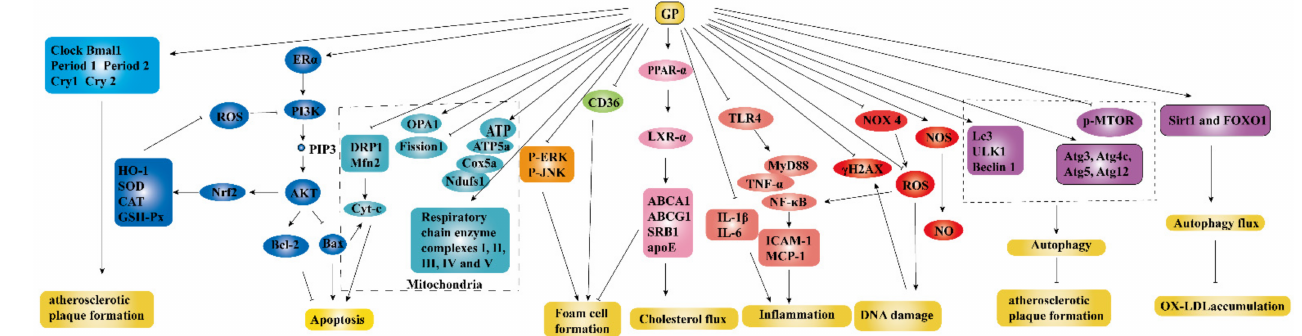
Figure 6. Anti-atherogenic effect of GP ↓ meant up-regulation, ⊥ meant